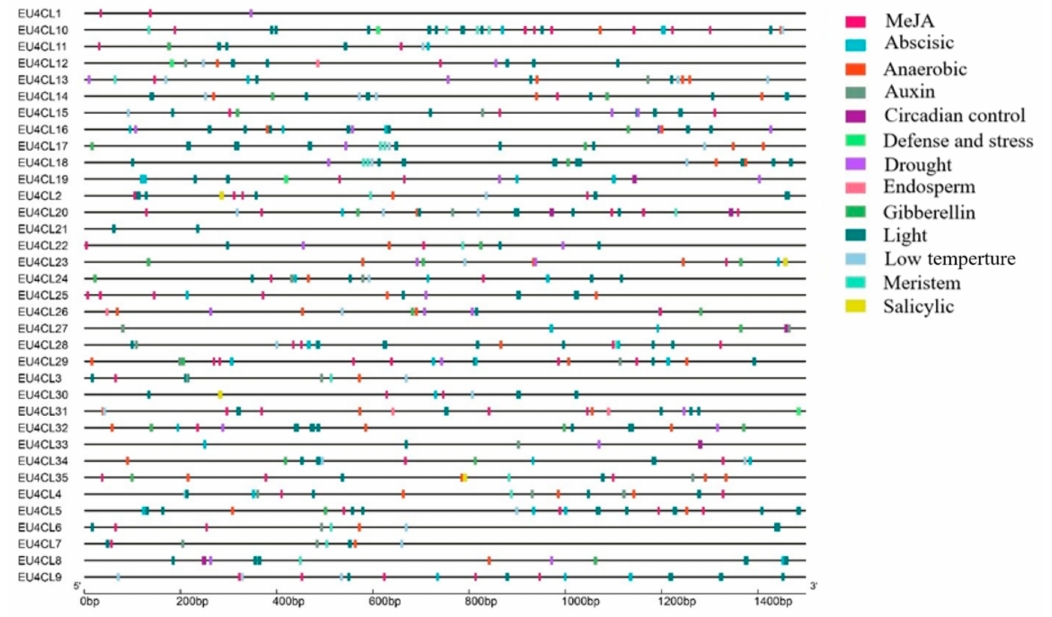
Figure 4. The cis-acting elements Analysis of Eu4CL genes